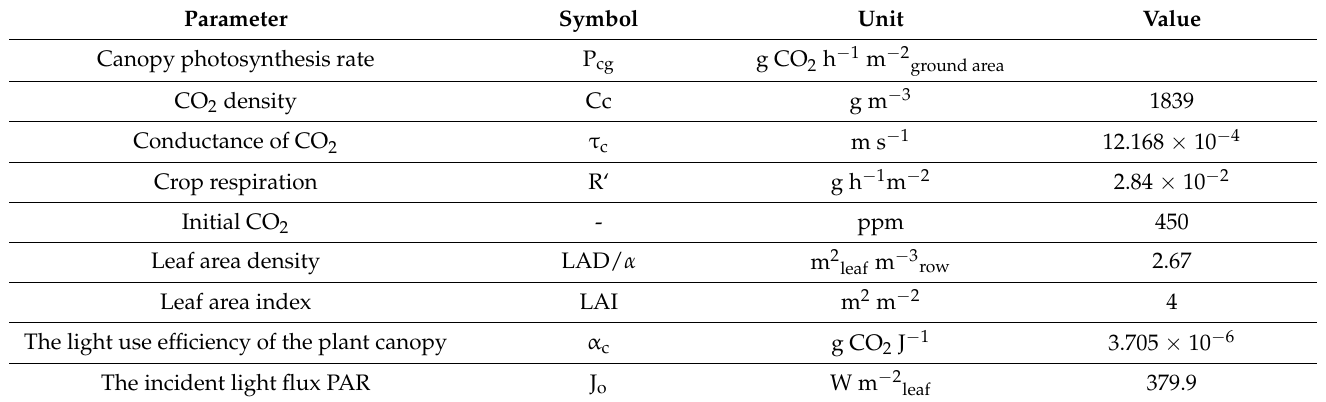
Table 1. Computational conditions used for the chamber model.